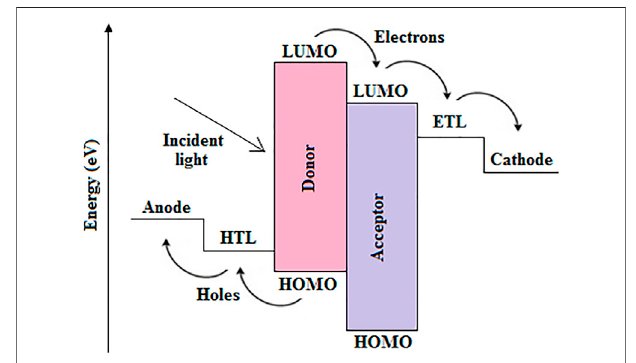
FIGURE 1 | Schematic energy level diagram of a typical